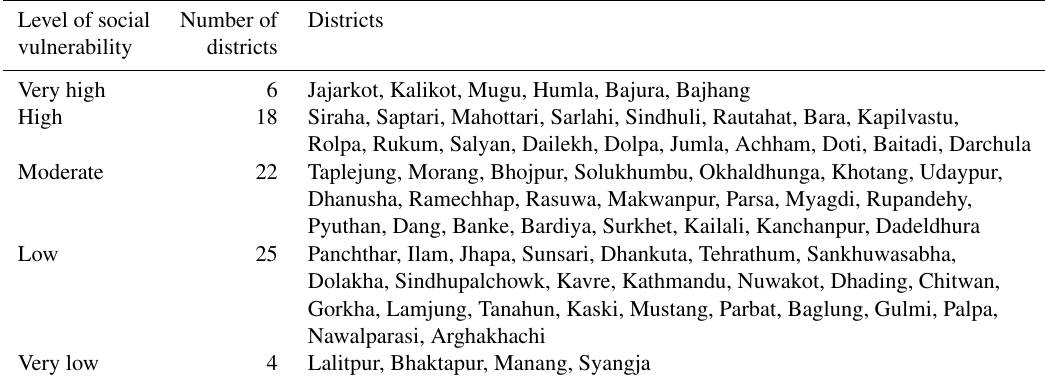
Table 4. Frequency of districts in terms of social vulnerability level. Level of social Number of Districts vulnerability